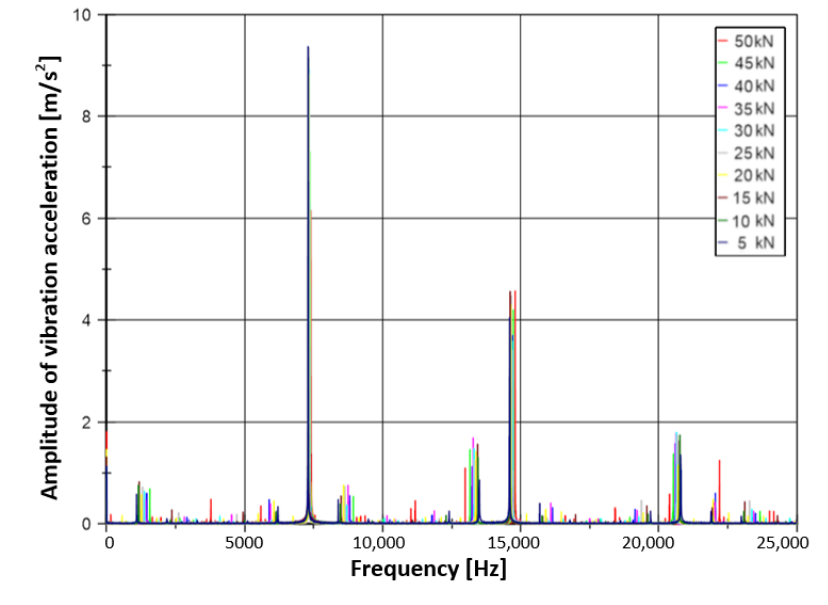
Figure 6. Frequency spectrum diagram of the signal calculated for one load cycle.